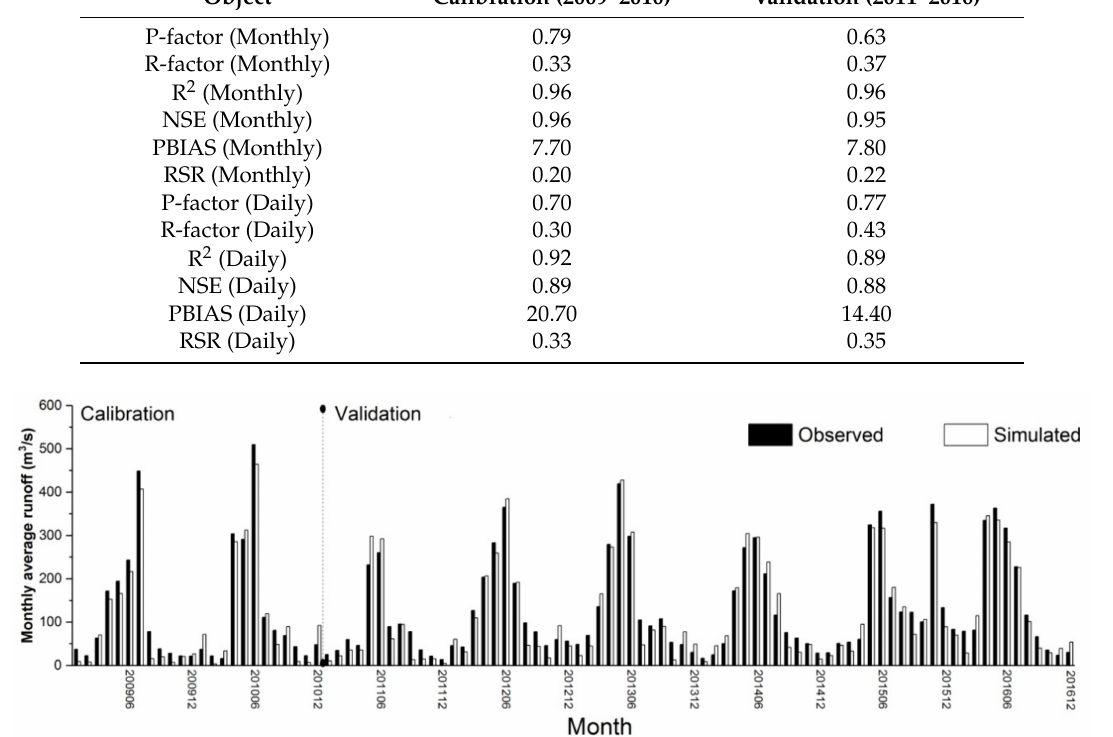
Figure 3. Comparison of monthly runoff using Soil and Water Assessment Tool (SWAT).